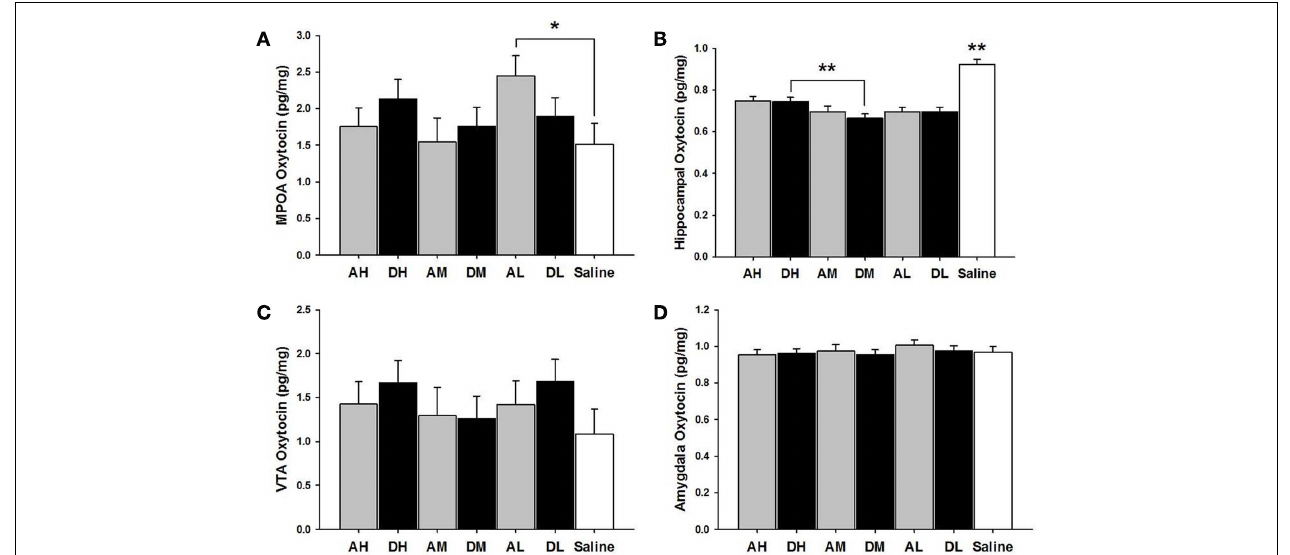
low (2.5mg/kg)], all desipramine groups in black [DH, desipramine high (5mg/kg); DM, desipramine medium (5mg/kg); DL, desipramine low (1.25mg/kg)] and saline control group in white [Saline = normal saline (2ml/kg)]. Comparisons between amitriptyline and desipramine groups were only tested between the high, medium, or low dose groups for each respective drug treatment group. All significant AH–DH, AM–DM, and AL–DL comparisons are denoted * p ≤ 0.05; ** p ≤